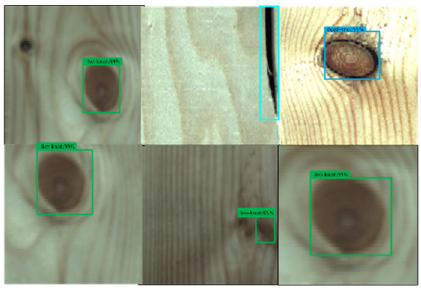
Figure 8. Recognition results based on the SSD algorithm.